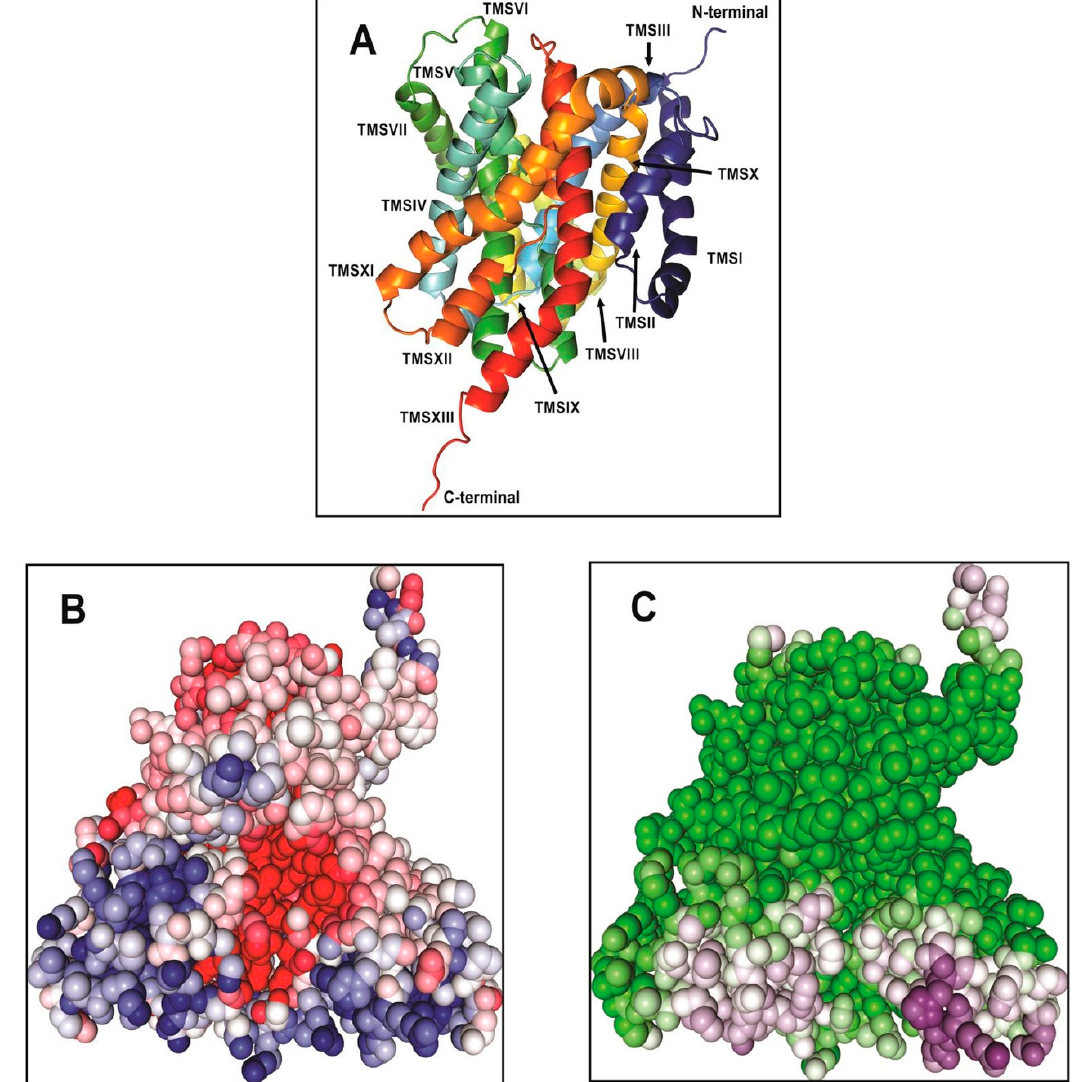
Figure 1. ( A ) The inward-open view of the structural model of the transmembrane domain of Vc-NhaP2. The structure was generated by Robetta and visualized by PyMOL 1.6 [34]. The model is shown in a rainbow of colors with TMSs numbered from I to XIII. ( B ) The electrostatic surface potential of Vc-NhaP2. A highly negatively charged (red colored) cavity is present in the middle of the Vc-NhaP2. The positively charged residues (blue colored) are lining the exterior of the antiporter. ( C ) The solvent accessible surface of Vc-NhaP2. The solvent accessible surface is indicated by the dark purple color. Solvent-inaccessible residues are green. The images for both electrostatic and solvent accessibility surface potential are generated by Protein-Sol (protein-sol.manchester.ac.uk) [35].